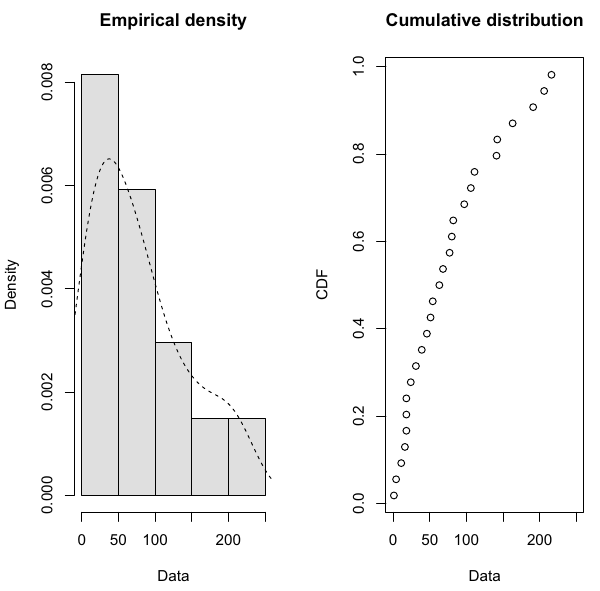
Figure 8. The Empirical density and cumulative distribution for the second sample of real